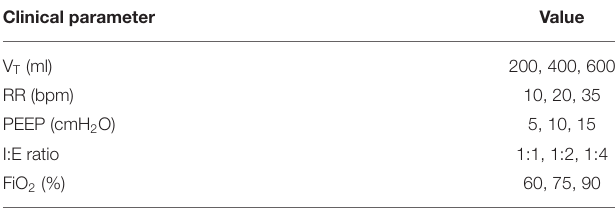
TABLE 1 | Range of input parameters tested for the ventilation parametric sweep. Clinical